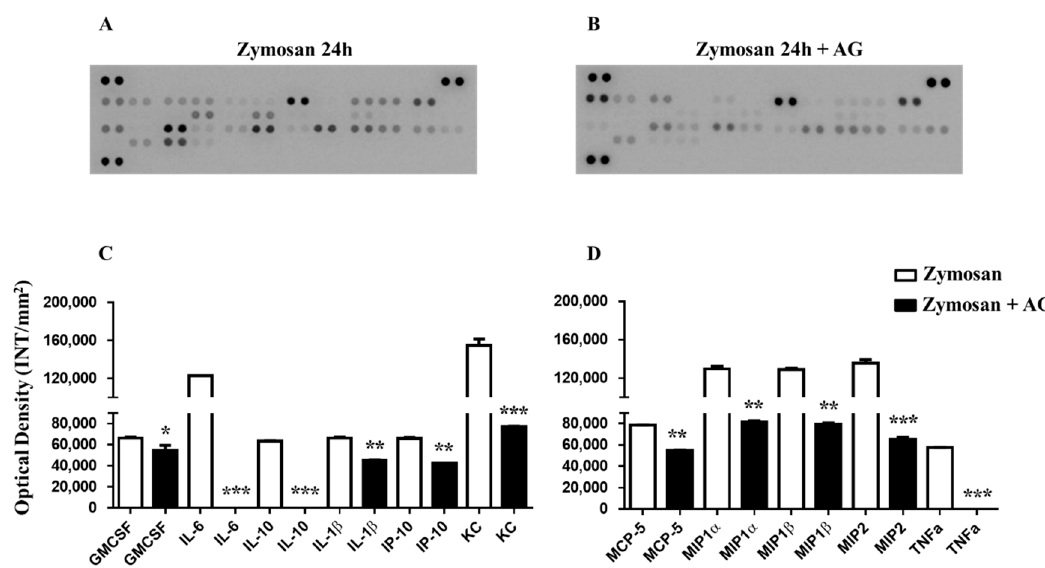
Figure 7. ( A ) Inflammatory fluids in zymosan and zymosan + AG-injected mice at 24 h. Inflammatory fluids obtained from peritoneal cavities were assayed using a proteome profiler cytokine array. ( B ) Mean changes (± S.E.M) between zymosan (500 mg/kg) and zymosan + AG-injected mice (150 mg/kg) of three separate experiments with n = 7 mice, ( C, D ) are expressed as increase in the optical density (INT/mm 2 ) between the two groups. * p < 0.05, ** p < 0.01 and *** p < 0.001 vs. zymosan-treated mice.